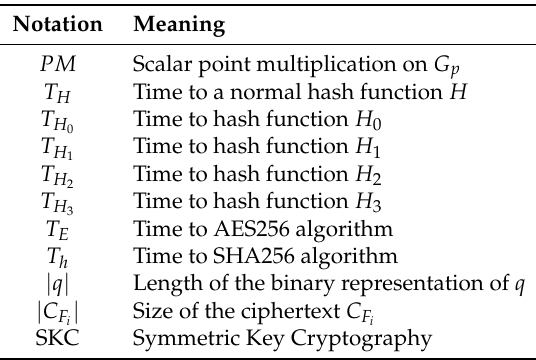
Table 2. The notations for different